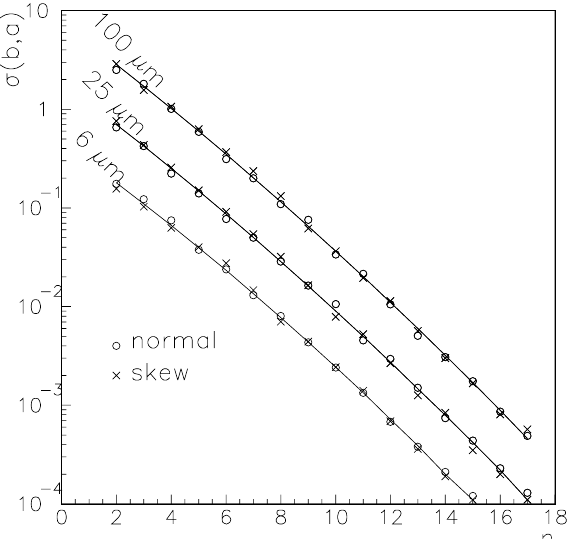
FIG. 2. Numerical estimate (markers) and parabolic fit (solid line) of the geometric random multipoles due to random block displacements of different amplitudes d for the six-block coil of the main LHC